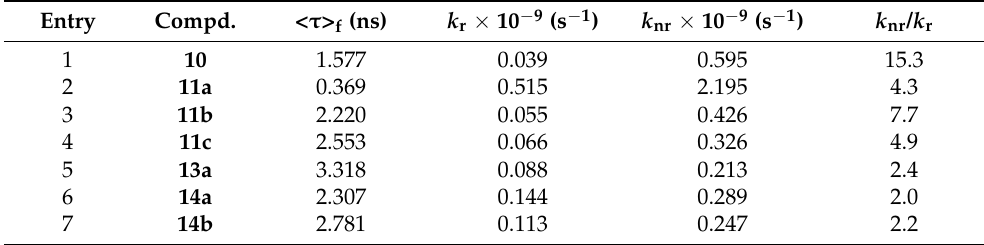
Table 2. The fluorescence lifetime (< τ > f ) and radiative ( k r ) and non-radiative ( k nr ) decay rate constants of DATs 10a , 11a – c , 13a , and 14a , b solutions in CHCl 3